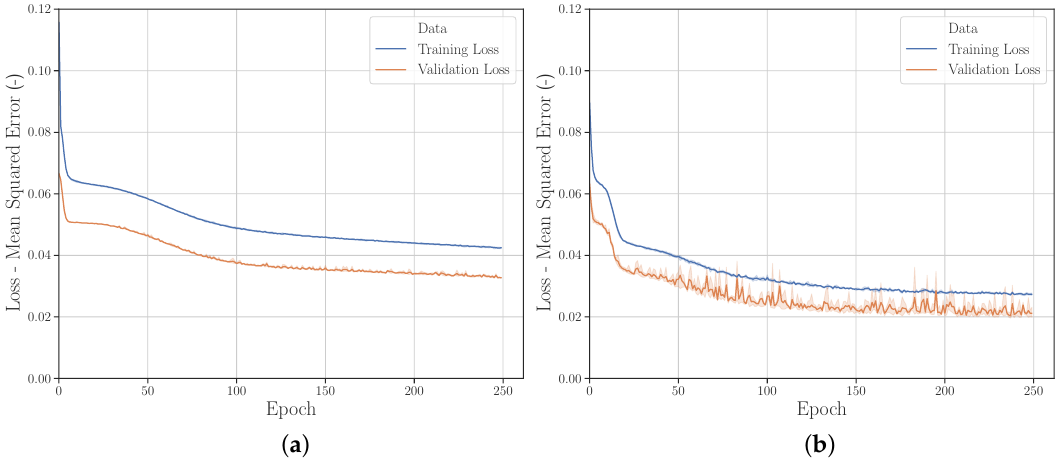
Figure 14. Learning curves with activation ( a ) Softmax and ( b ) Hard Sigmoid .